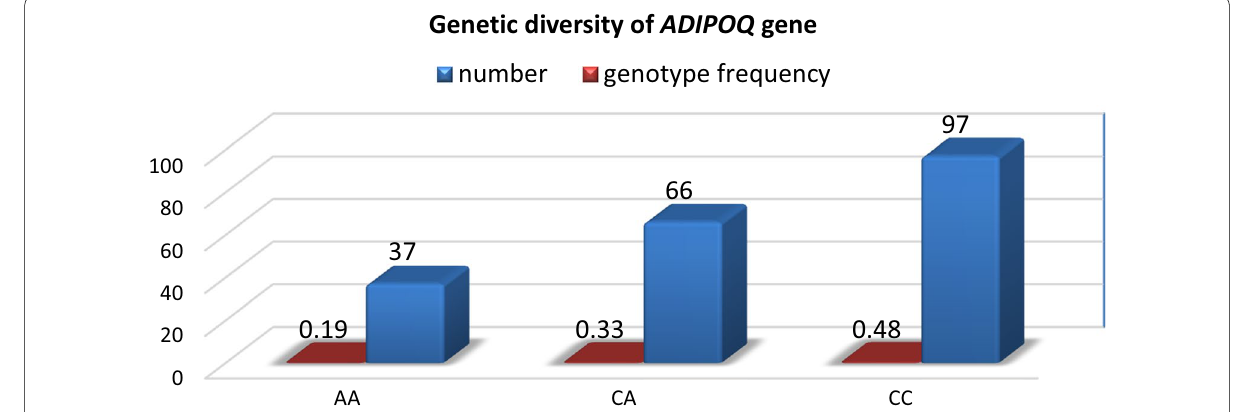
Fig. 3 Genetic diversity of the ADIPOQ gene exhibited the most preponderant genotype was CC